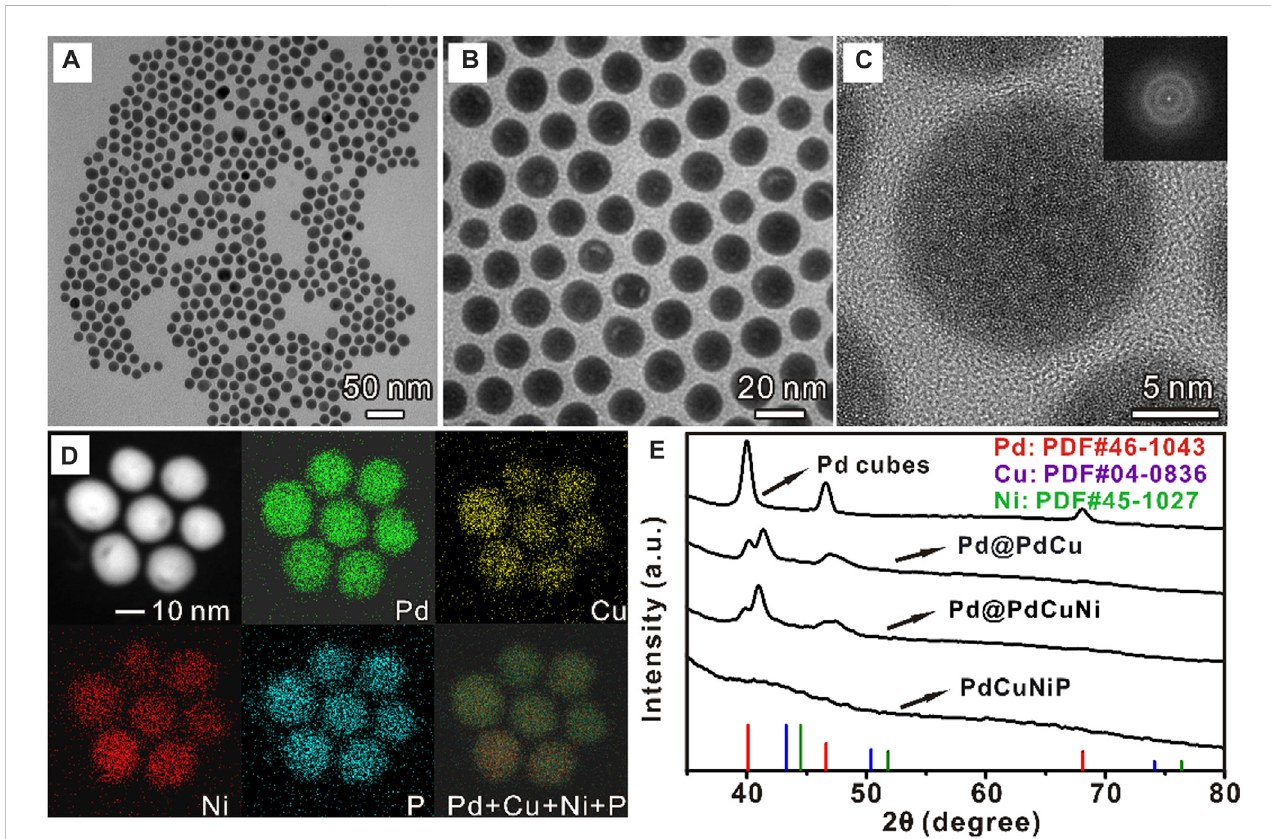
FIGURE 1 (A, B) TEM image, (C) HRTEM image, (D) EDS mappings of PdCuNiP nanoparticles, and (E) XRD patterns of Pd nanocubes, Pd@PdCu, Pd@PdCuNi, and PdCuNiP